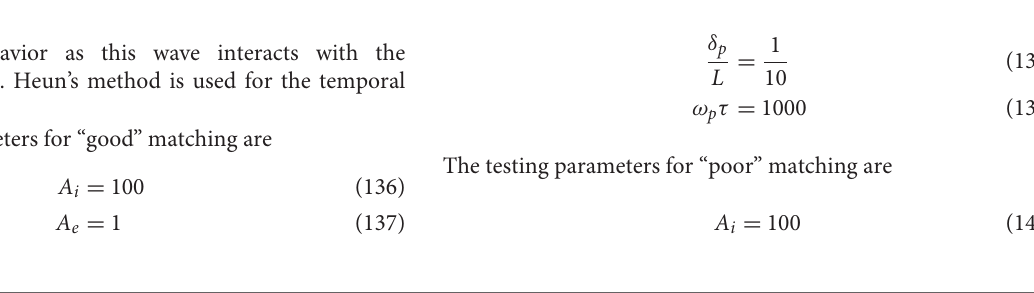
FIGURE 13 | Contours of the electron distribution function at t x [ 128, 96] and x [96,128] are modeled with the continuum kinetic two-species plasma model, and the middle subdomain x ∈ − − ∈ 5 N -moment two-fluid plasma model.